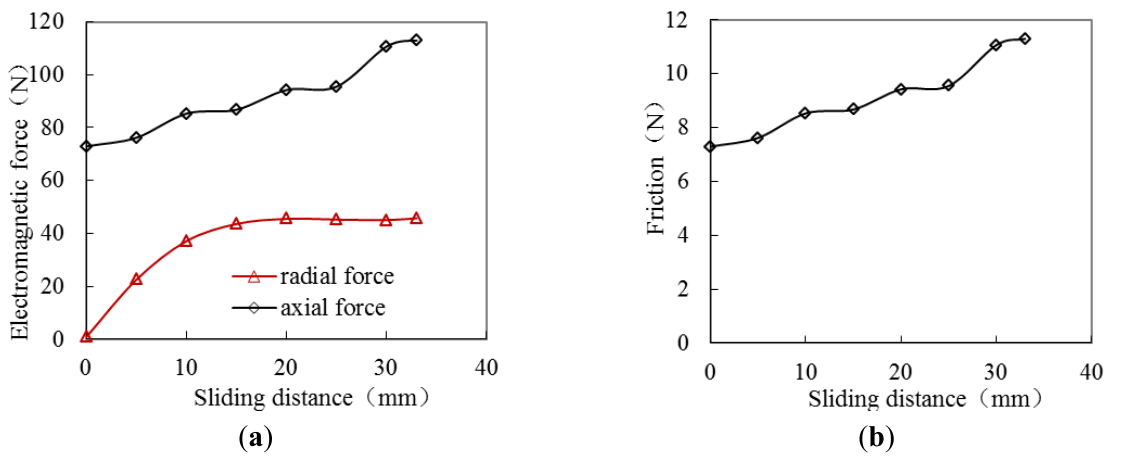
Figure 21. Relationship between electromagnetic force and friction and PMs sliding distance: ( a ) electromagnetic force, ( b ) friction.